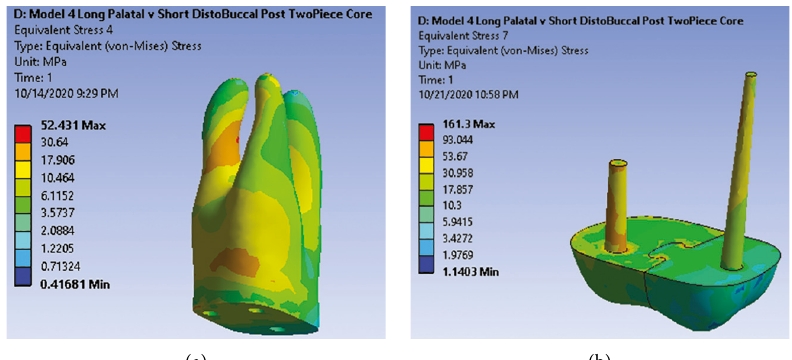
Figure 5: (a) Stress distribution pattern in dentin under 480 (N) along model 4. (b) Stress distribution pattern in post-core under 480 (N) along model